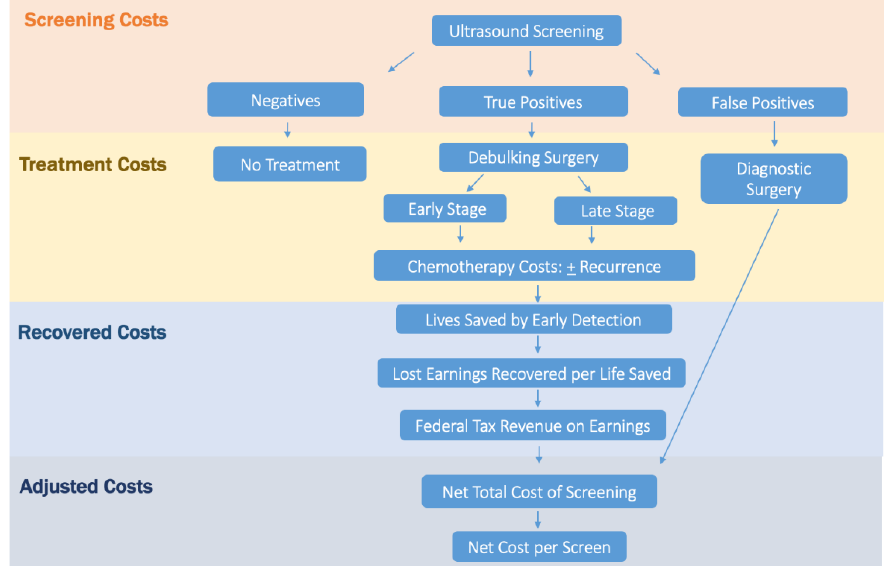
Figure 1. Schematic representation of the amended step-wise approach used in this analysis to estimate the adjusted net total cost and adjusted net cost per screen of the Kentucky trial. the adjusted net total cost and adjusted net cost per screen of the Kentucky